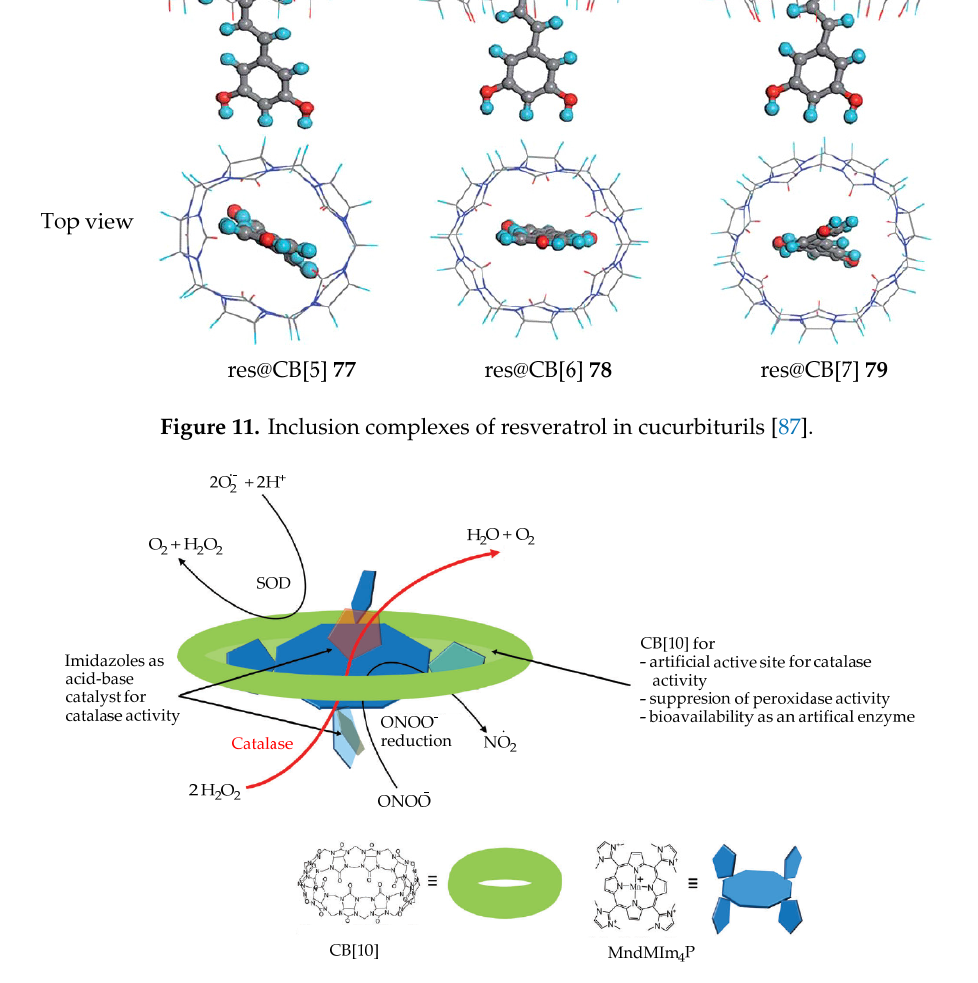
Figure 11. Inclusion complexes of resveratrol in cucurbiturils [87].